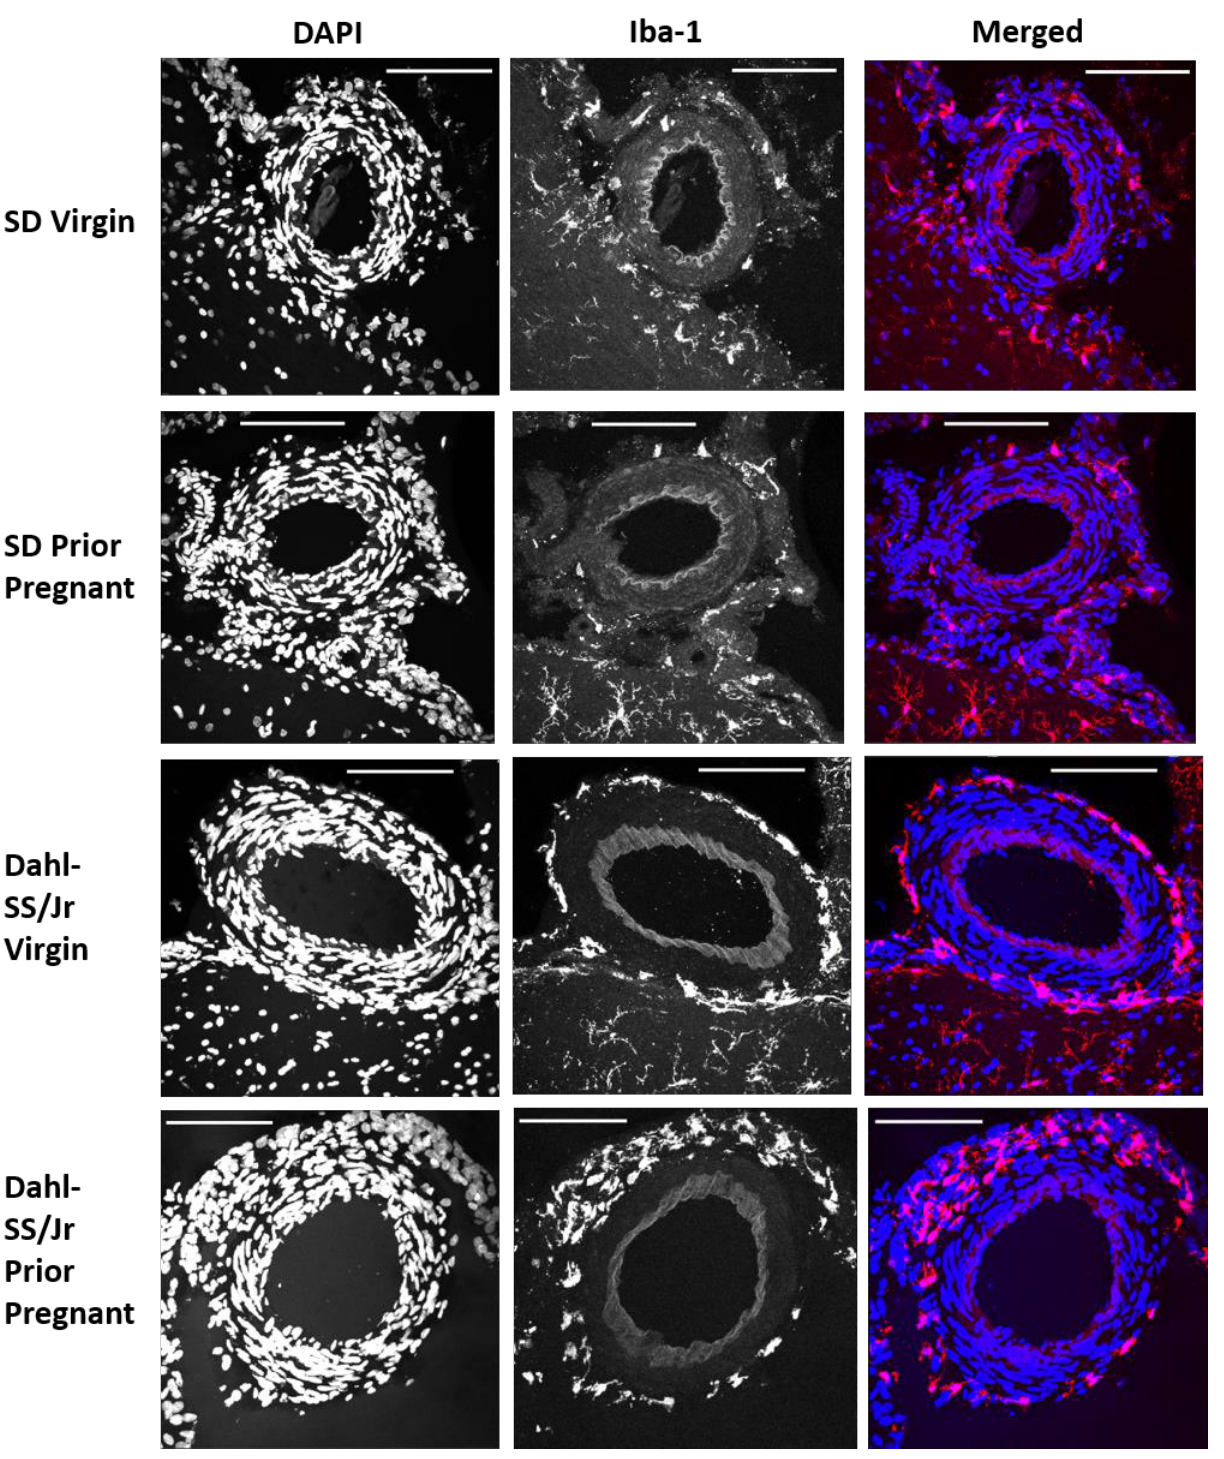
Figure 1. Representative maximum projection confocal images of pial vessels from each group. Brain sections were stained for Iba1 and co-stained using DAPI. Pial vessels from SD virgin, SD prior pregnant, Dahl-SS/Jr virgin, and Dahl-SS/Jr prior pregnant rats are shown. Microglia/macrophages (Iba1+) are red and nuclei (DAPI+) are blue. Scale bar = 50 µ